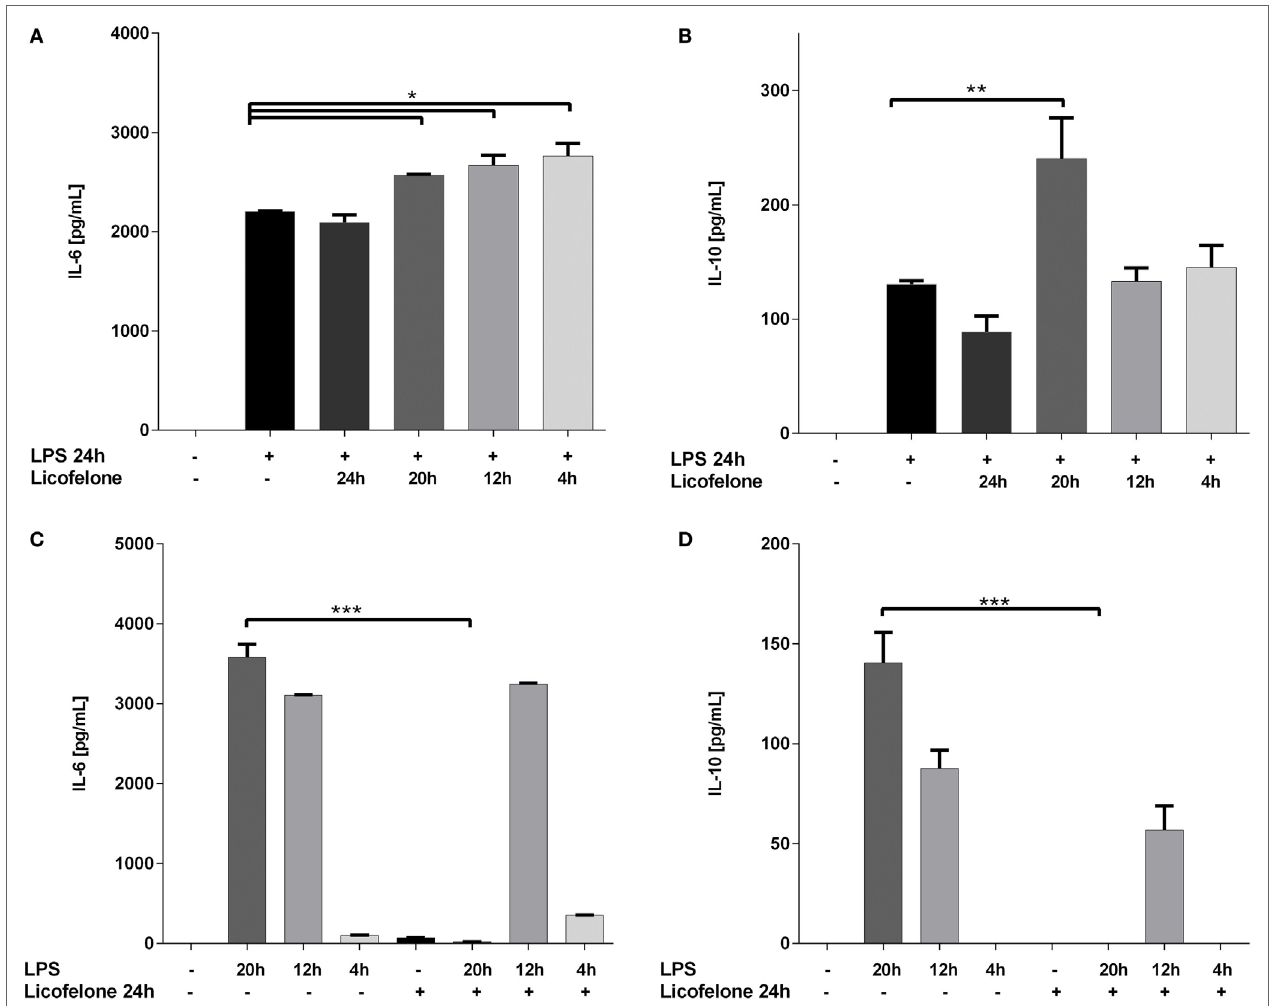
FigUre 4 | licofelone increases il-6 (a,c) and il-10 (b,D) production when added to lPs-stimulated cells but decreases the production of the two cytokines when added prior to lPs stimulation . IMCs generated from the BM of tumor-bearing mice with GM-CSF (20 ng/mL) and PGE 2 (9.1 μ g/mL) for 5 days. Cells were treated either with licofelone (5 μ M) and/or LPS (50 ng/mL) alone as described. Data shown are mean + SD of pooled groups from two independent experiments. *** p <